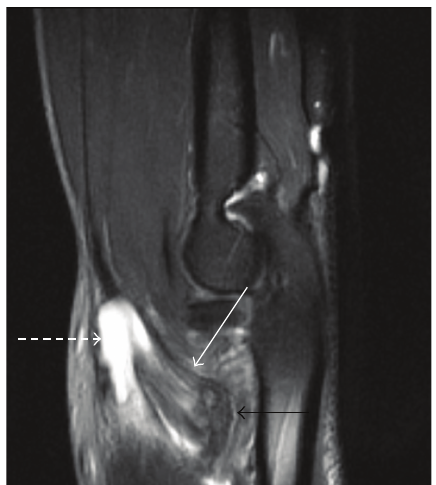
Figure 1: Sagittal STIR image (TR: 5900; TE: 28) of the elbow de- monstrating thickening and increased solid in the distal biceps ten- don consistent with high-grade partial tearing (solid white arrow). Note associated fluid in the bicipitoradial bursa (dashed white arrow) and osseous changes at radial tuberosity (solid black